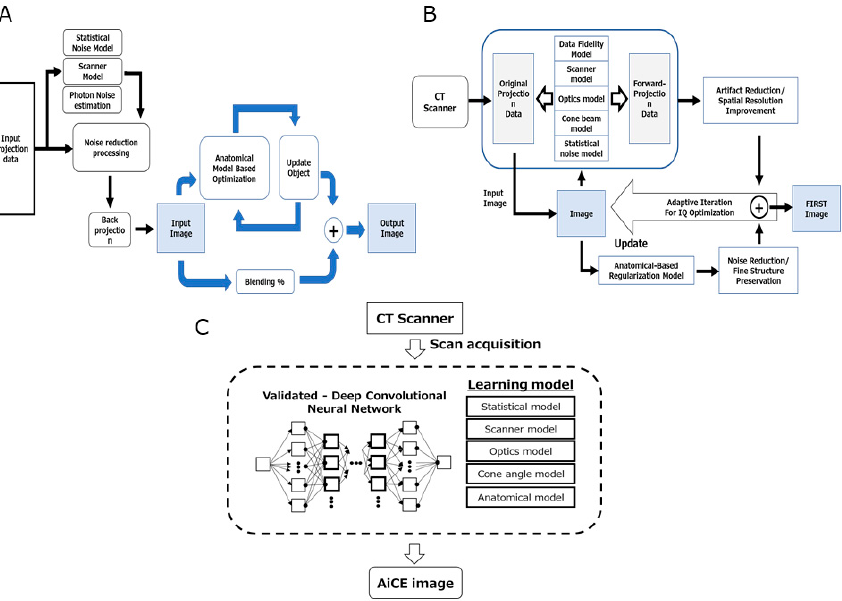
Figure 1. Schematic diagram of the image reconstruction methods. ( A ) Adaptive Iterative Dose Reduction 3D; ( B ) Forward-projected model-based Iterative Reconstruction SoluTion; ( C ) Advanced intelligent Clear-IQ Engine.